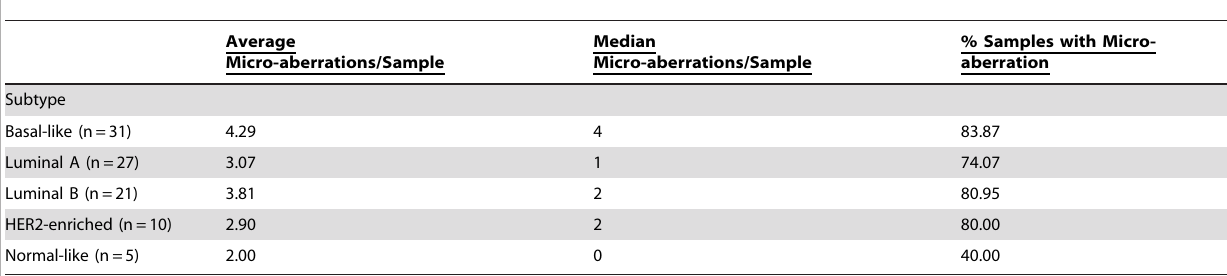
Table 1. Copy Number Micro-aberrations by